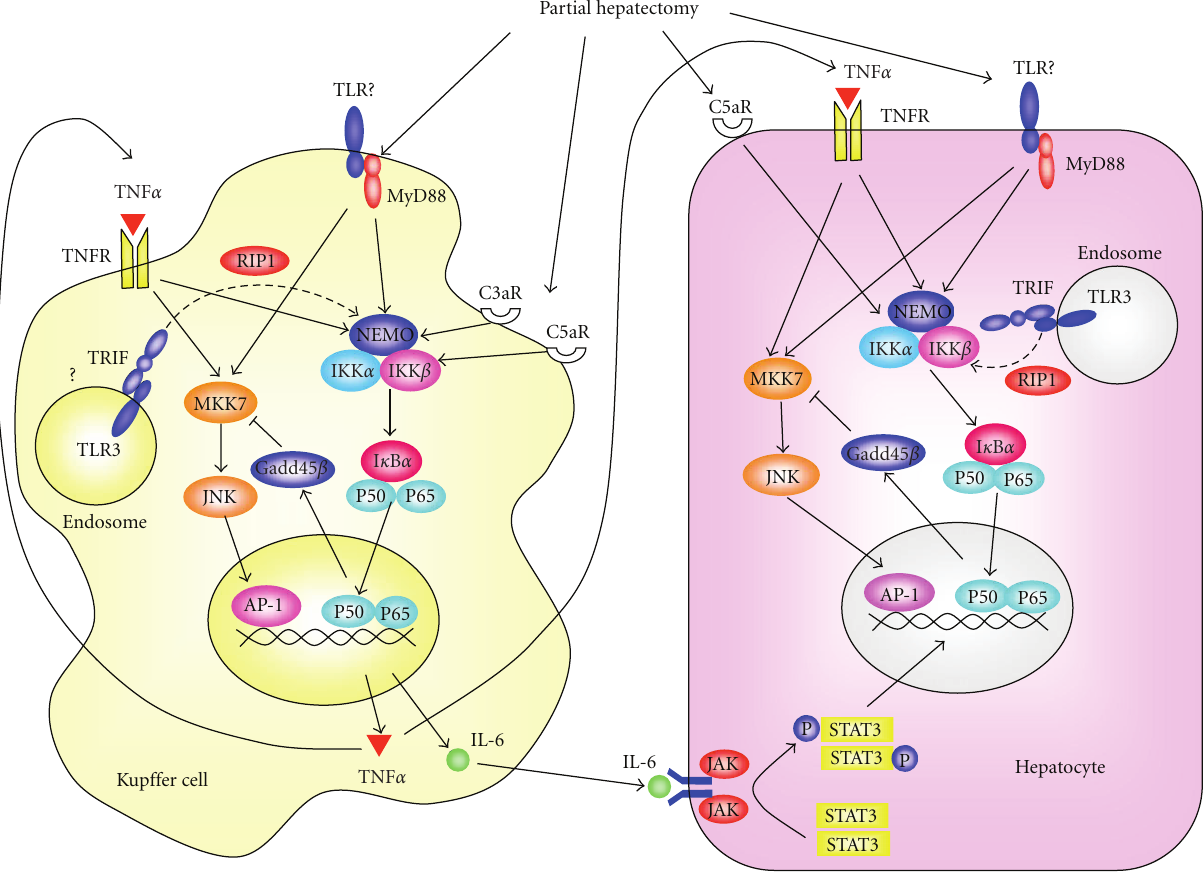
Figure 1: Signal transduction pathways during the priming phase of liver regeneration. Interactions between Kup ff er cells and hepatocytes are also illustrated while other nonparenchymal cells are also possibly involved. AP-1, activator protein; C3aR, activated compliment 3 receptor; C5aR, activated compliment 5 receptor; Gadd45 β , growth arrest and DNA-damage-inducible gene 45 β ; IKK, inhibitor of nuclear factor κ B kinase; IL-6, interleukin-6; JAK, Janus-associated kinase; JNK, c-jun N-terminal kinase; MKK7, mitogen-activated protein kinase 7; MyD88, myeloid di ff erentiation factor 88; NEMO, nuclear factor κ B essential modulator; RIP, receptor interacting protein; TLR, toll-like receptor; TNF α , tumor necrosis factor α ; TRIF, TIR-domain containing adaptor inducing interferon- β